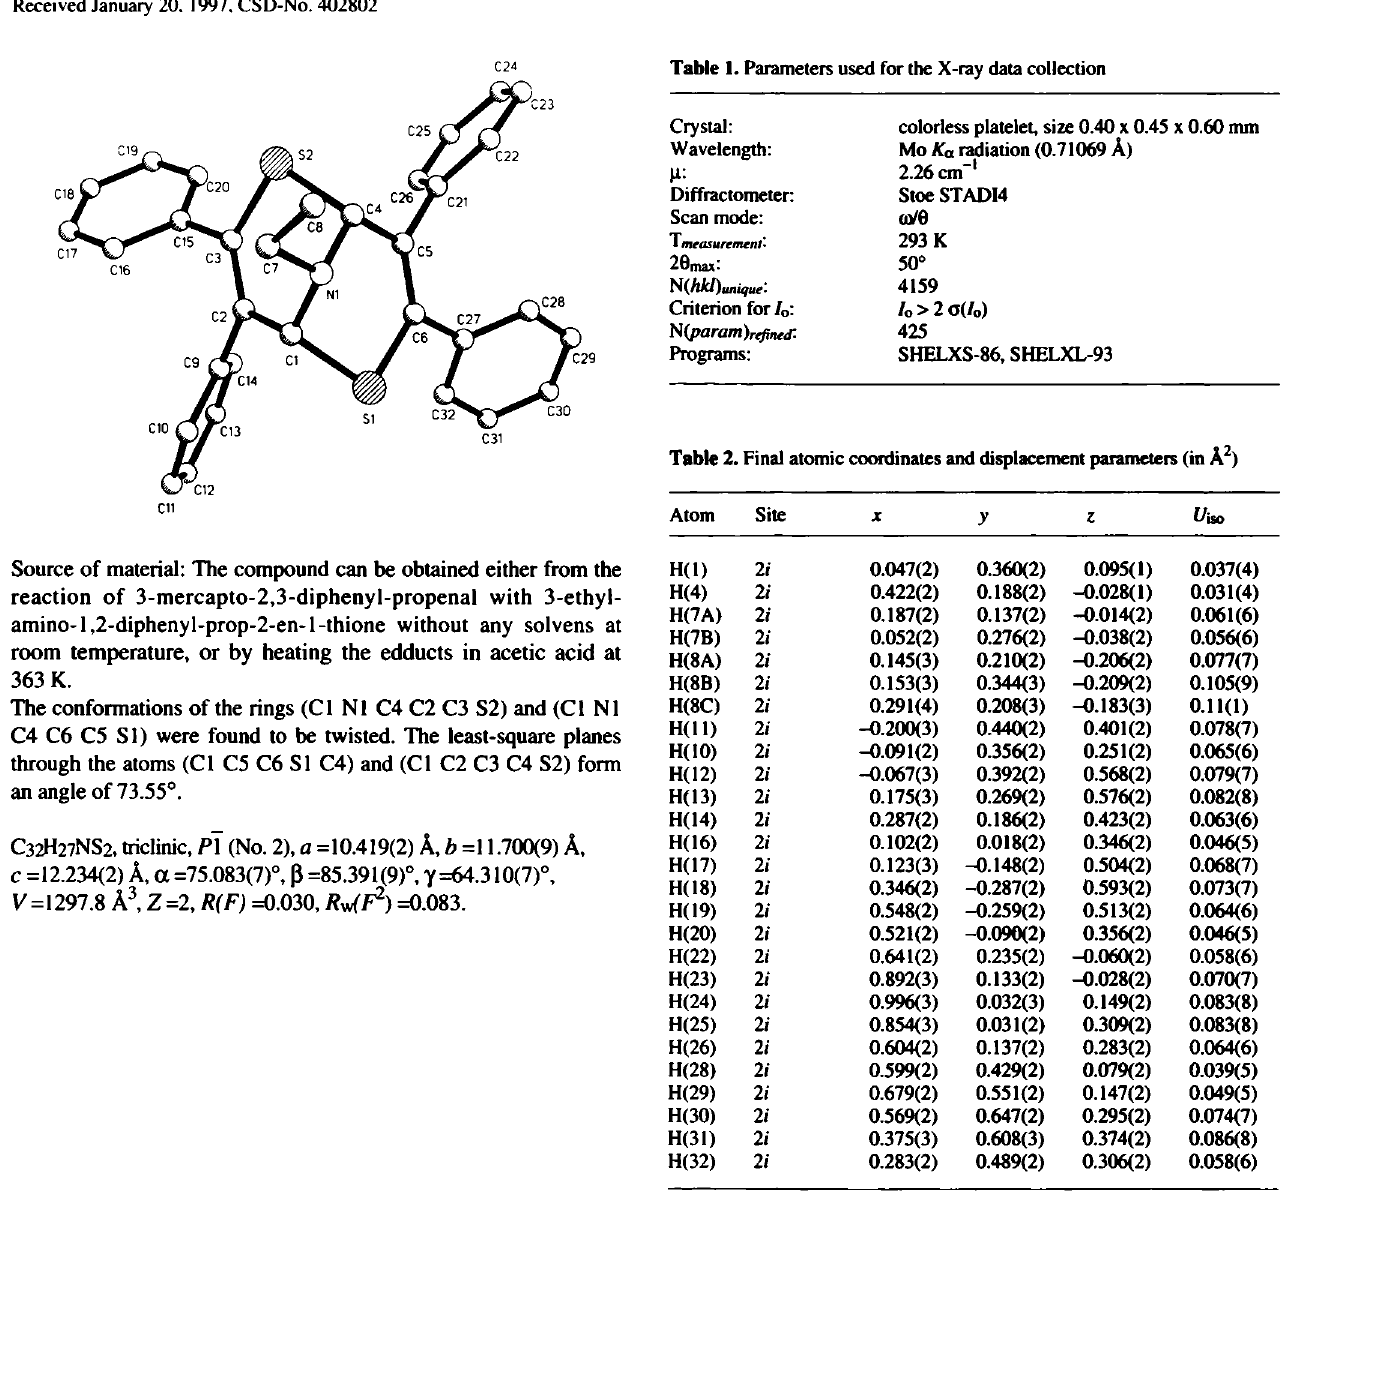
Table 1. Parameters used for the X-ray data collection Crystal: